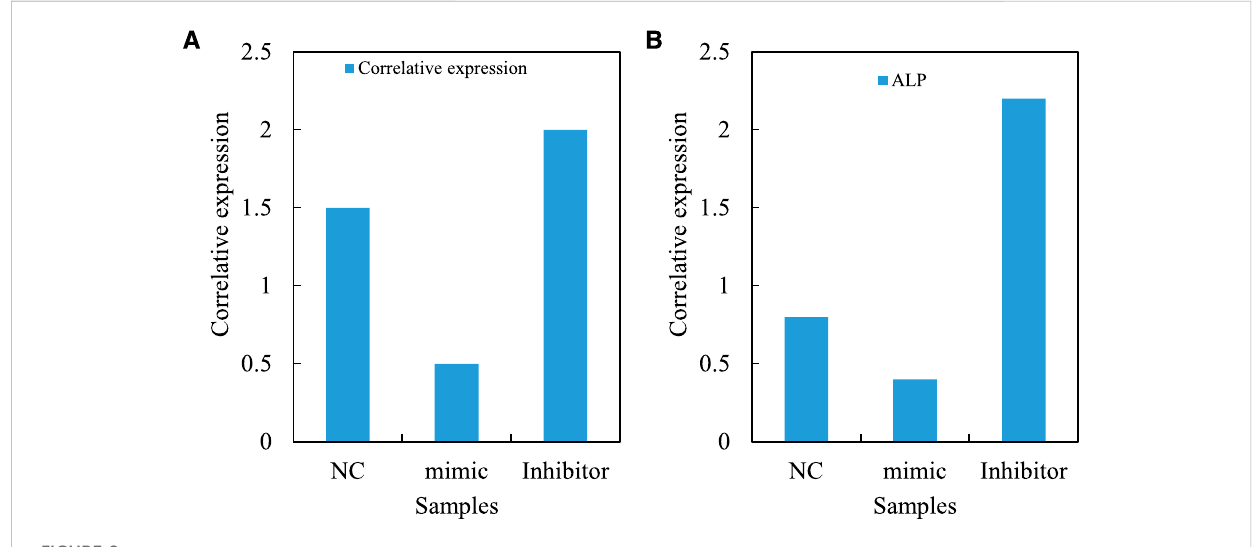
FIGURE 8 Regulation of hypoxic avascular necrosis of femoral head. (A) VEGF/PI3K/AKT signal pathway (B) ALP.